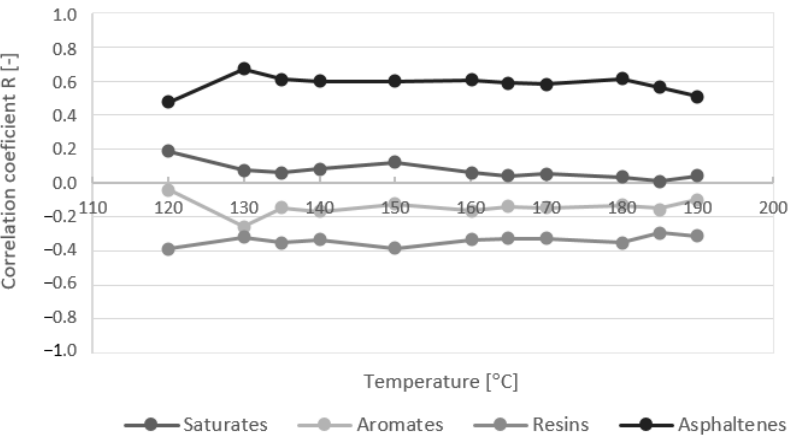
Figure 8. Example of correlation coefficient R of a linear model of dynamic viscosity and group composition at temperatures in the range 120 to 190 °C for group paving grade bitumen samples (50/70 and 35/50).